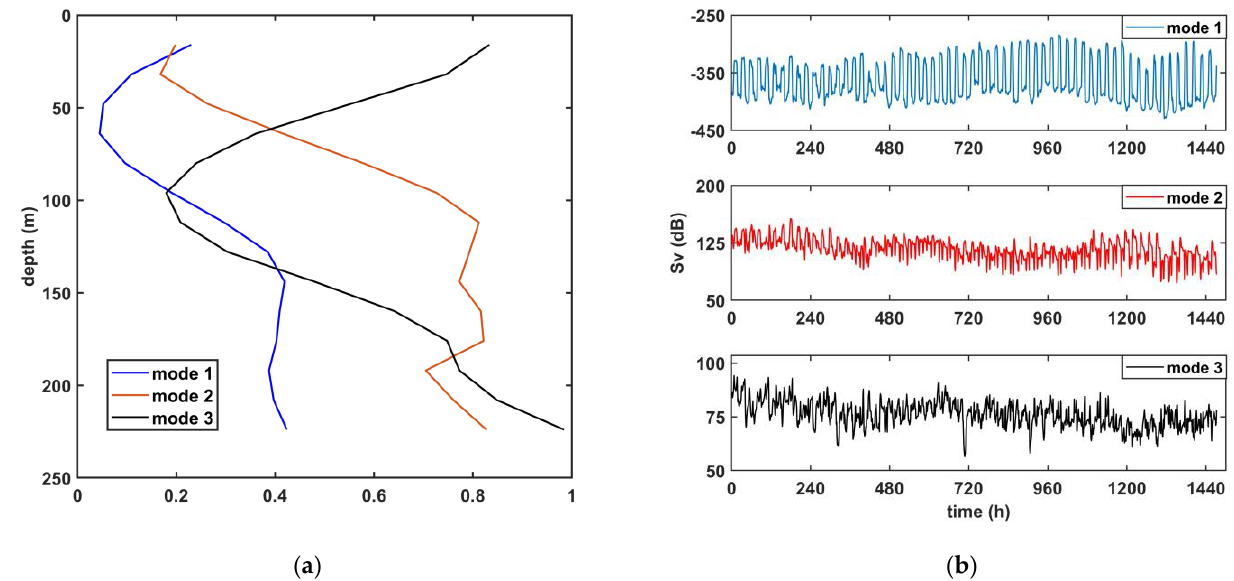
Figure 5. ( a ) The first three modes ’ profiles of the EOF decomposition of the ADCP data acquired at M2; ( b ) time series of the first three modes ’ coefficient of the EOF decomposition of the ADCP data acquired at M2.